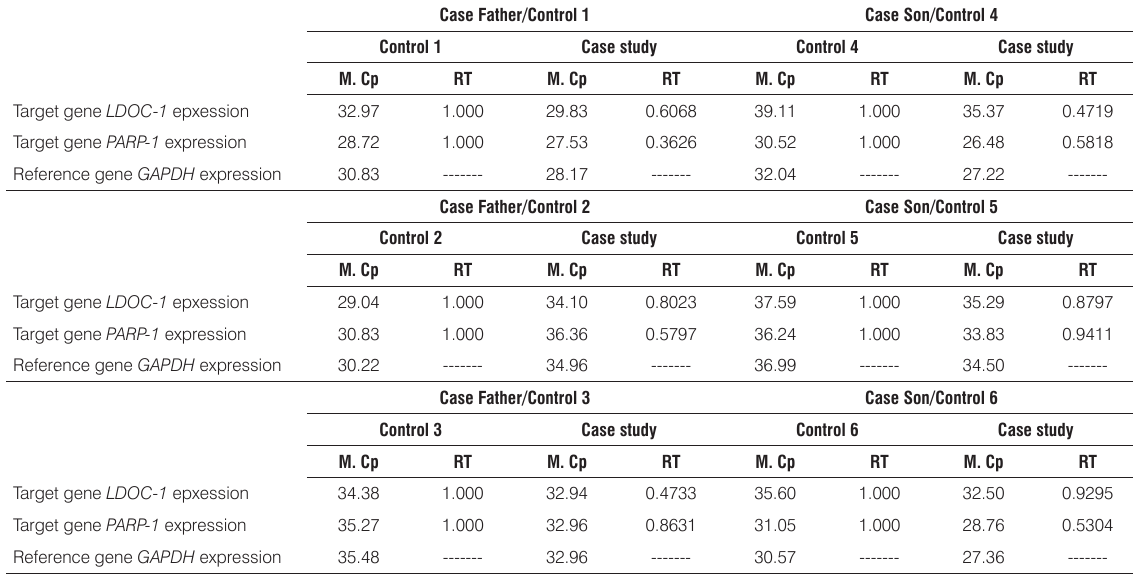
Table 1. Expression of LDOC-1 and PAR-1 mRNA in two patients (father and son) with cutaneous malignant melanoma compared with six normal healthy